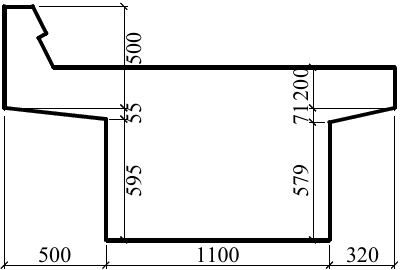
Figure 4. Cross-section of the test beam (unit: mm).